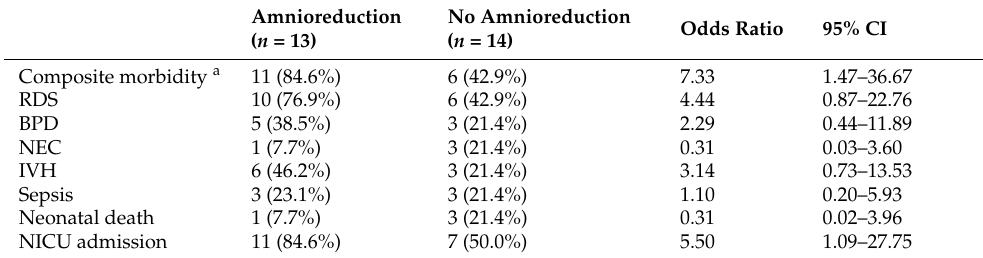
Table 3. Neonatal outcomes of living fetuses of propensity score-matched